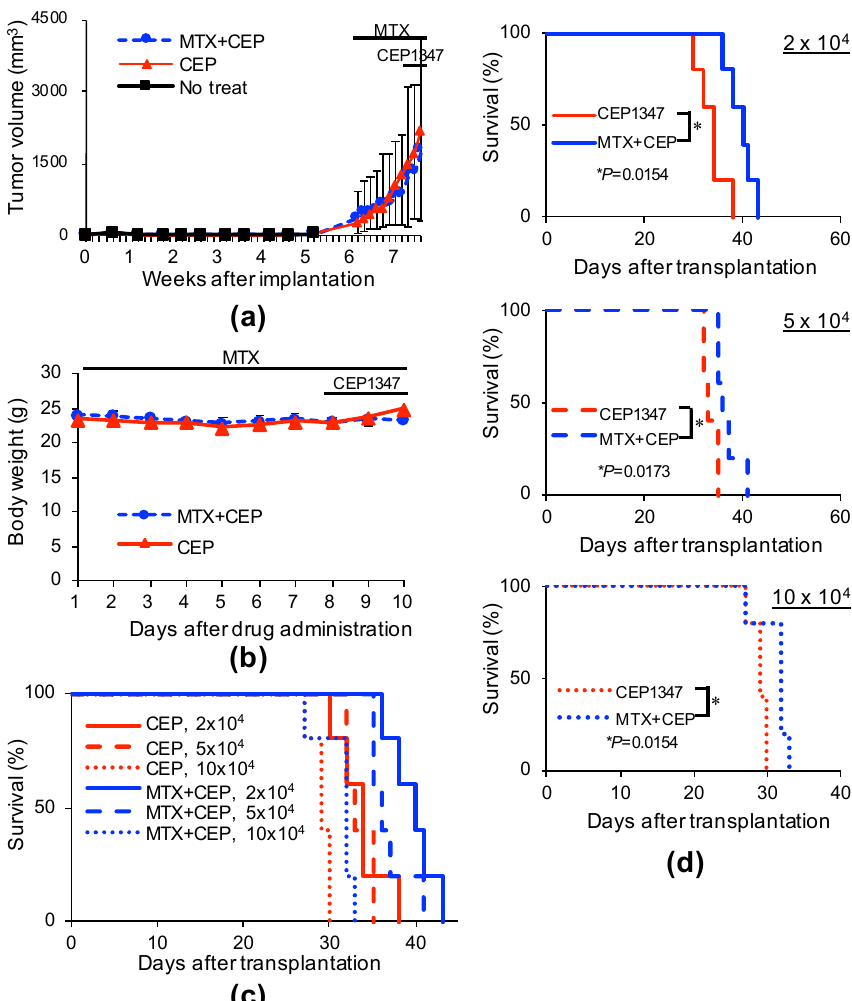
Figure 6. Systemic administration of MTX cooperates with CEP1347 to inhibit tumor-initiating cells in tumors in tumor-bearing mice. ( a , b ) Mice implanted subcutaneously with GS-Y03 (1 × 10 6 cells) were randomized into 2 treatment groups (3 mice per group) 6 weeks after implantation, when the average primary tumor volume reached approximately 300 mm 3 , and received a daily intraperitoneal injection of CEP1347 (CEP; 1.5 mg/kg/day) for 3 consecutive days, as indicated schematically in ( a , b ). Mice in the MTX + CEP group received an additional daily intraperitoneal injection of MTX (50 mg/kg/day) followed by intraperitoneal leucovorin (50 mg/kg/day, 4 h after MTX) for 10 consecutive days, which started at the time of randomization and 1 week before the administration of CEP1347. In the combination (MTX + CEP) group, MTX was administered 6 h before CEP1347. One day after the final drug treatment, the subcutaneous tumors were excised and dissociated. Then, the serial dilutions of the dissociated tumor cells were transplanted intracranially into new mice. The volume of the primary tumors treated with CEP1347 or MTX + CEP1347 (MTX + CEP) was assessed at the indicated time points and is presented in the graph as the mean ± SD ( a ), and body weight was monitored at the indicated time points ( b ). Kaplan–Meier survival curves of the mice ( n = 5 for each group) are shown ( c ). For clarity, the survival curves of mice transplanted with 2 × 10 4 (upper), 5 × 10 4 (middle), or 10 × 10 4 (lower) cells are shown separately in ( d ). * p < 0.05 vs. CEP1347-treated mice by the log-rank test.